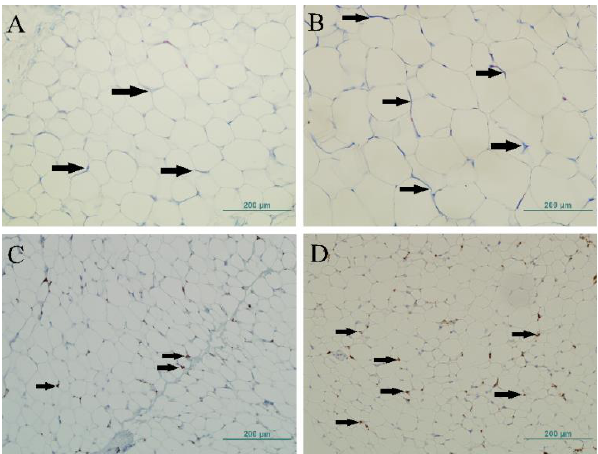
Figure 1. Masson’s trichrome staining of subcutaneous adipose tissue in ( A ) a normal-weight and ( B ) an overweight male child. The arrows indicate pericellular collagen (blue color). Magnification: 200×, scale bar 200 µm. The immunohistochemistry for CD163 cells in visceral adipose tissue in ( C ) a normal-weight and ( D ) an overweight male child. The arrows point to positively stained cells (macrophages). Magnification: 200×, scale bar 200 µm. The images were taken from representative samples.